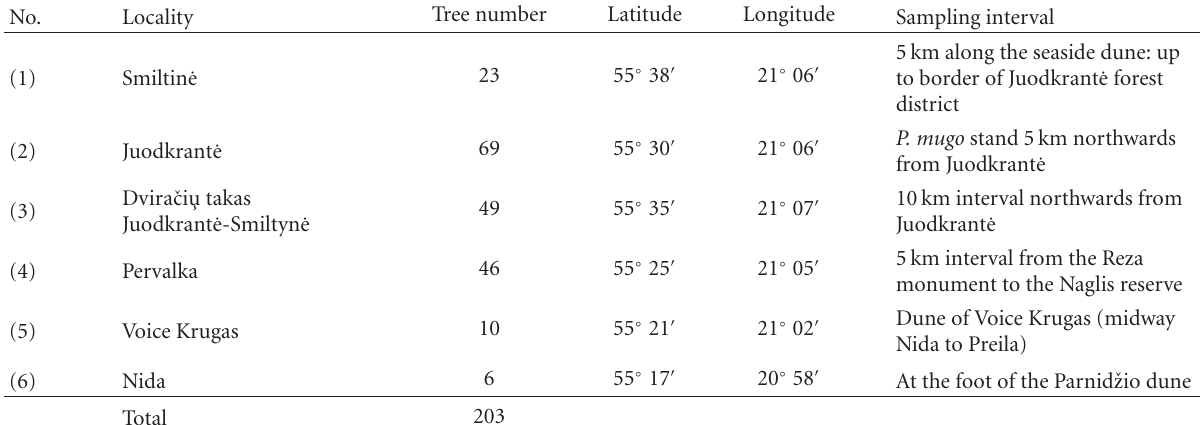
Table 1: The localities and number of sampled putative P. mugo × sylvestris hybrids at each locality in Kursiu Nerija. Altitude of the localities varied from 5 to 20 m. a.s.l.. For the sampling interval, the geographical coordinates indicate the midpoint of the interval. The localities follow the order towards the south (Figure